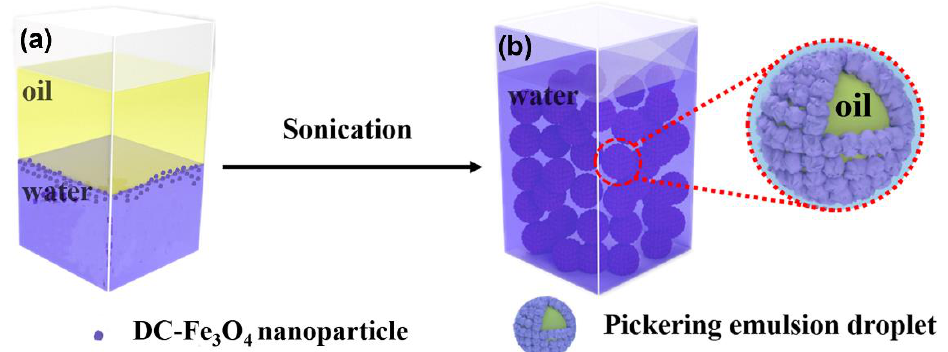
Figure 4. Preparation process of Pickering emulsion stabilized by DC-Fe 3 O 4 with a volume ratio of liquid paraffin and water of 1:1. ( a ) The mixture of liquid paraffin, water and DC-Fe 3 O 4 nanoparticles before sonication, ( b ) the obtained Pickering emulsions after sonicating the mixture of liquid paraffin, water and DC-Fe 3 O 4 nanoparticles in (a).